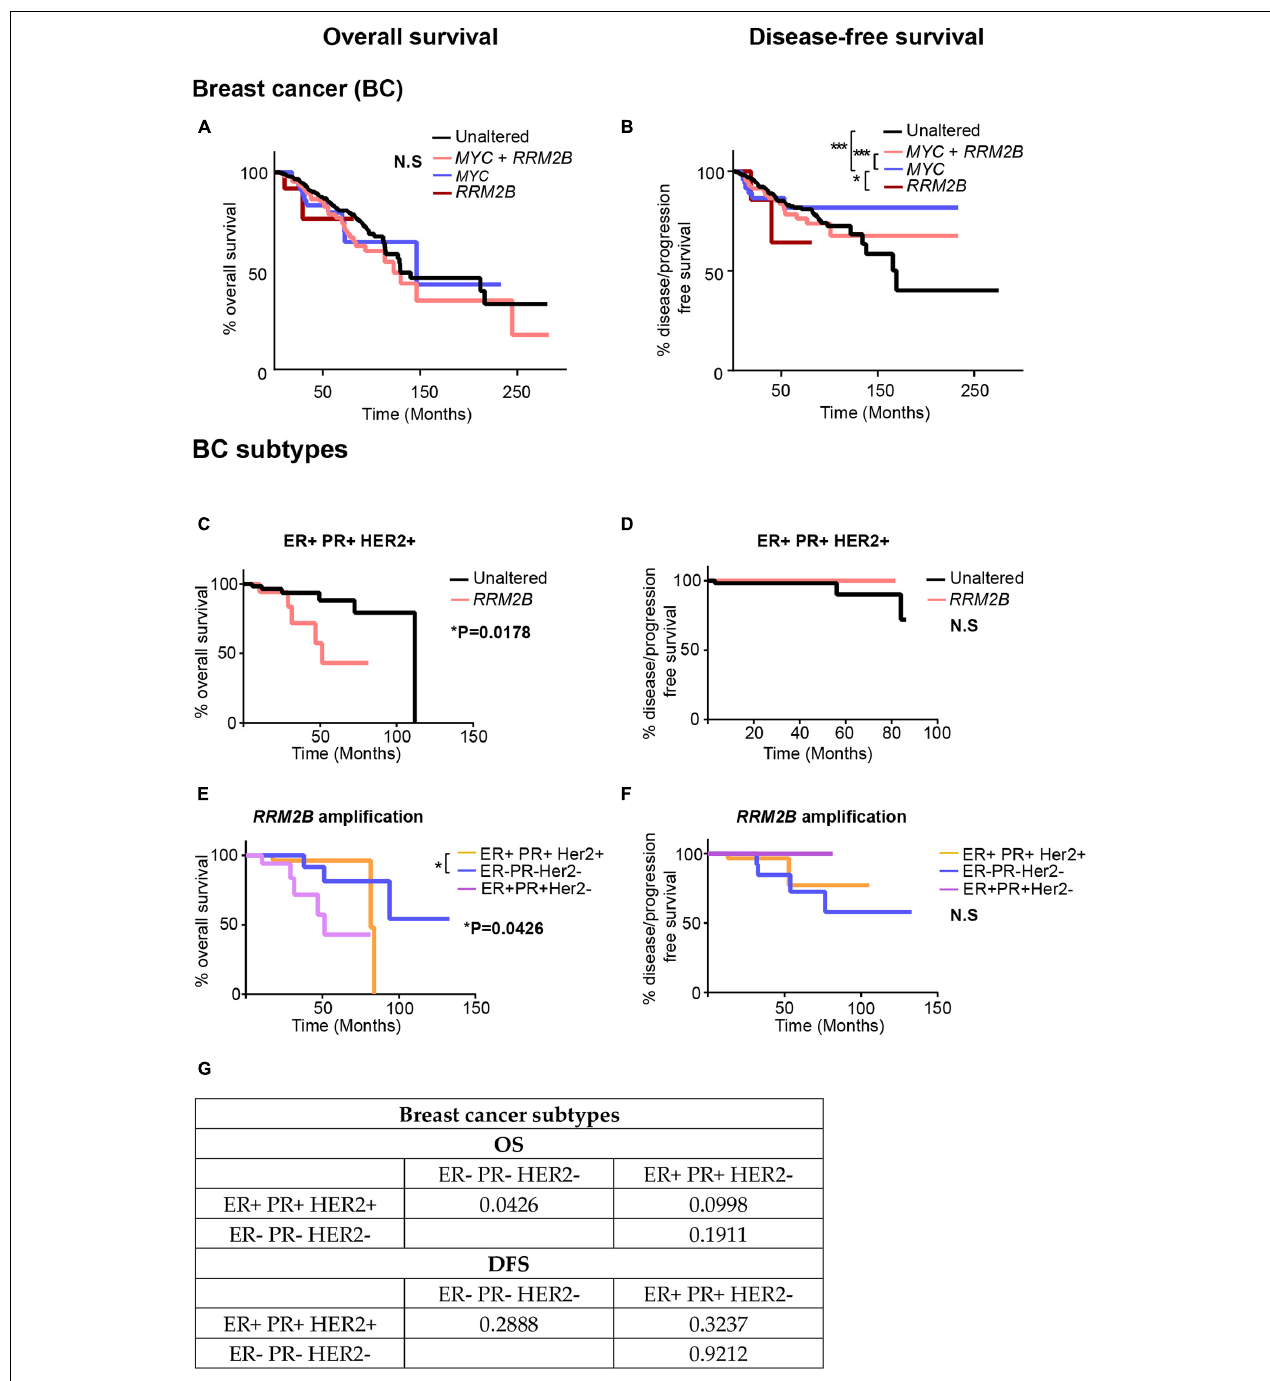
FIGURE 6 | Kaplan-Meier curves for OS and DFS in breast cancer (BC) (A,B) and its subtypes (C–G) studies with RRM2B amplifications and/or MYC amplifications. (A) OS in BC cases. The cases that were unaltered for both genes (black, n = 737), cases with RRM2B amplifications (red, n = 14), cases with MYC amplifications (blue, n = 62) and co-amplifications (pink, n = 210) were plotted. (B) DFS in BC cases. The cases that were unaltered for both genes (black, n = 678), cases with RRM2B amplifications (red, n = 12), cases with MYC amplifications (blue, n = 55) and co-amplifications (pink, n = 184) were plotted. (C) OS in ER + PR + HER2 + BC cases. The cases that were unaltered for RRM2B (black, n = 68), cases with RRM2B amplifications (salmon, n = 18). (D) DFS in ER + PR + HER2 + cases. The cases that were unaltered for RRM2B (black, n = 63), cases with RRM2B amplifications (red, n = 13). (E) OS in BC subtypes with RRM2B amplifications. ER + PR + HER2 + cases with amplifications in RRM2 B (purple, n = 18), ER- PR- HER2- cases with amplifications in RRM2B (blue, n = 26), and ER + PR + HER2- cases with amplifications in RRM2B (peach, n = 36). (F) DFS in BC subtypes with RRM2B amplifications. ER + PR + HER2 + cases with amplifications in RRM2 B (purple, n = 13), ER- PR- HER2- cases with amplifications in RRM2B (blue, n = 25), and ER + PR + HER2- cases with amplifications in RRM2B (peach, n = 34). The plots were compared using Log-rank test and significance is shown as follows: * P < 0.05, ** P < 0.01, and *** P < 0.001. (G) P- values for the graphs (E,F)